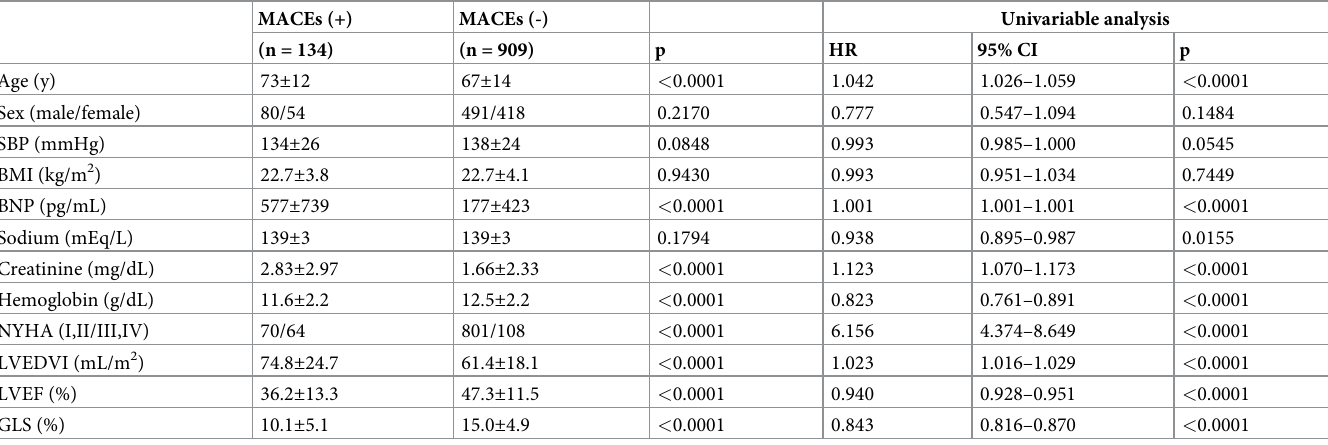
Table 3. Univariable cox proportional analyses for MACEs in the derivation